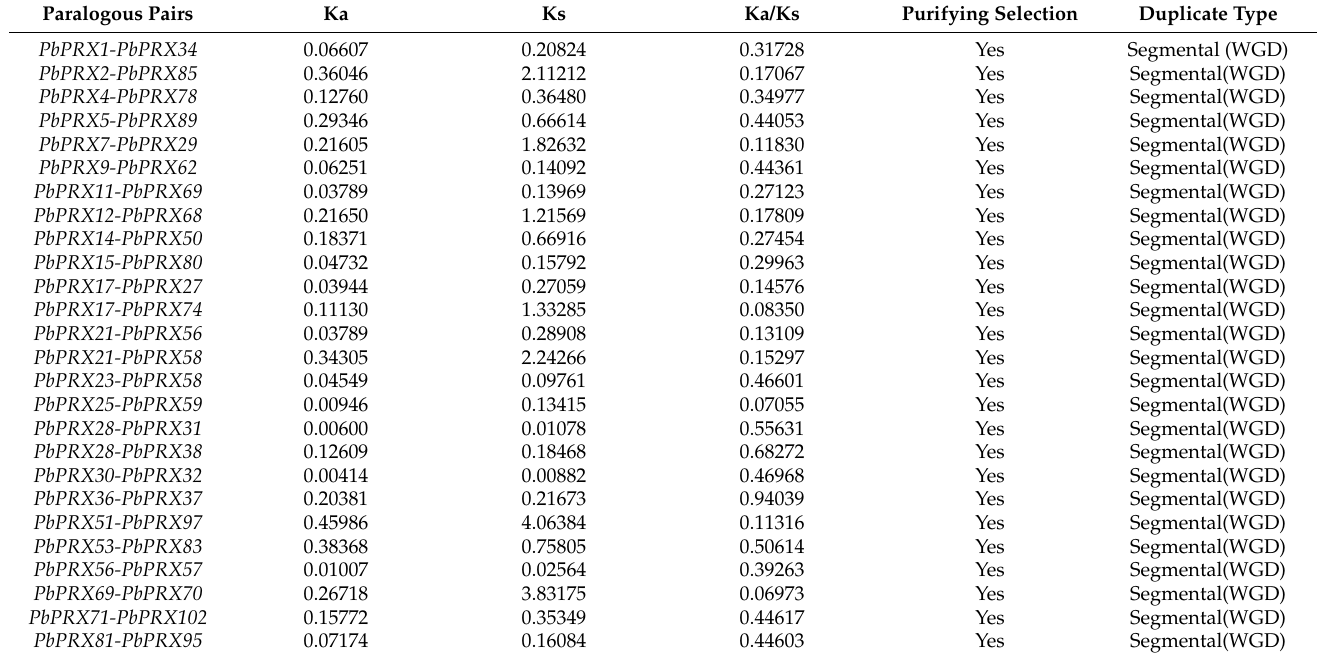
Table 3. Duplicated gene pairs, Ka, Ks value, and duplicate type of PbPRX gene family. Paralogous Pairs Ka Ka/Ks Purifying Selection Duplicate